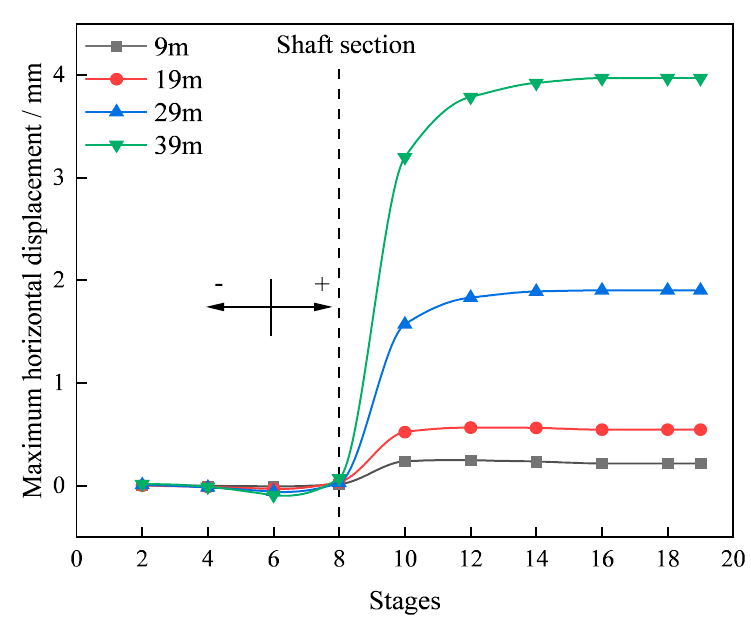
Figure 20. Horizontal displacement curve of the side wall.